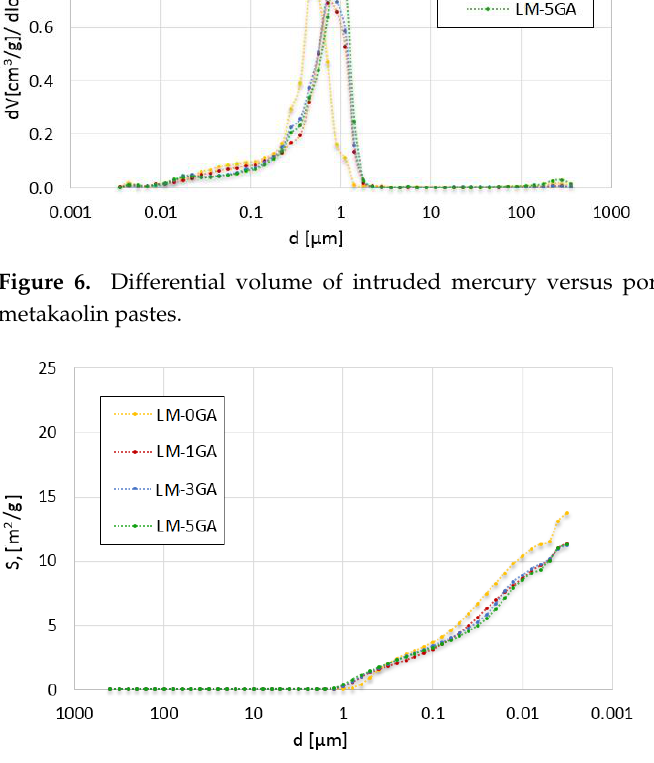
Figure 7. Total pore surface versus pore diameter for the tested lime-metakaolin pastes.